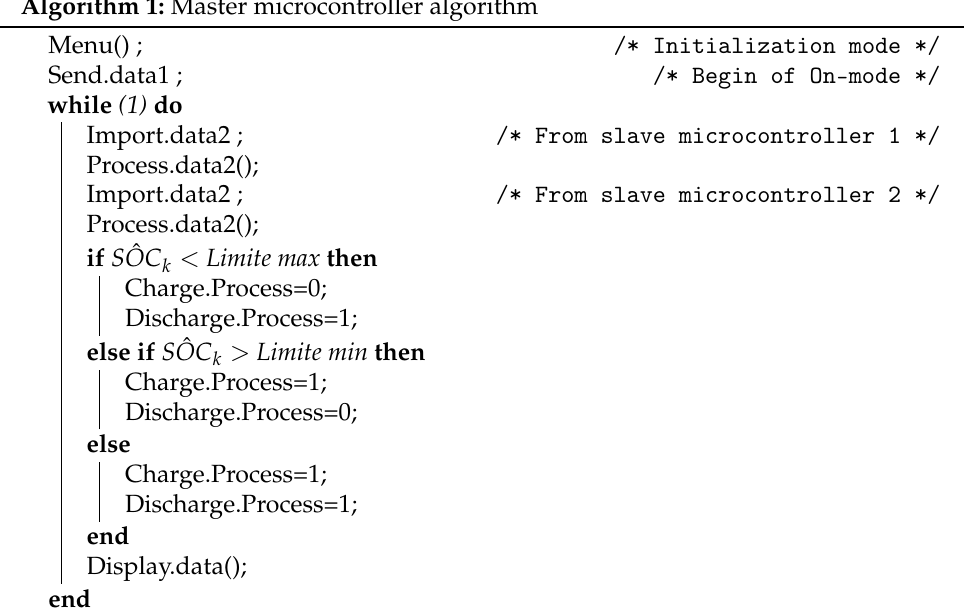
Algorithm 1: Master microcontroller